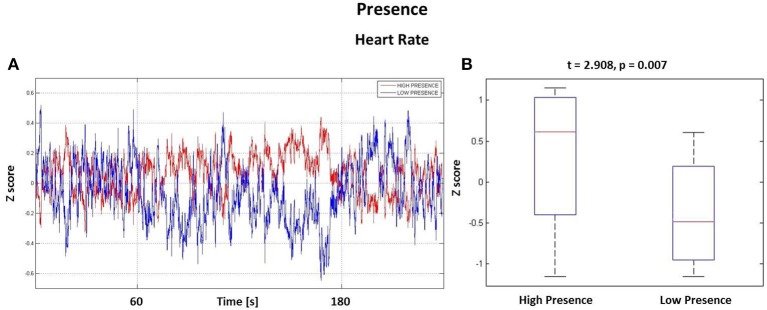
Results from the Heart Rate analysis. (A) HR waveforms for the High Presence (red) and Low Presence (blue) conditions. Vertical grid highlights the time window tm, the central part of experience, where the highest difference was found. (B) Boxplots showing the z-score distributions of High and Low Presence conditions computed in the time interval tm. On each box, the central mark is the median, the edges of the box are the 25th and 75th percentiles, the whiskers extend to the most extreme data points. Difference is significant with t = 2.908 and p = 0.007.